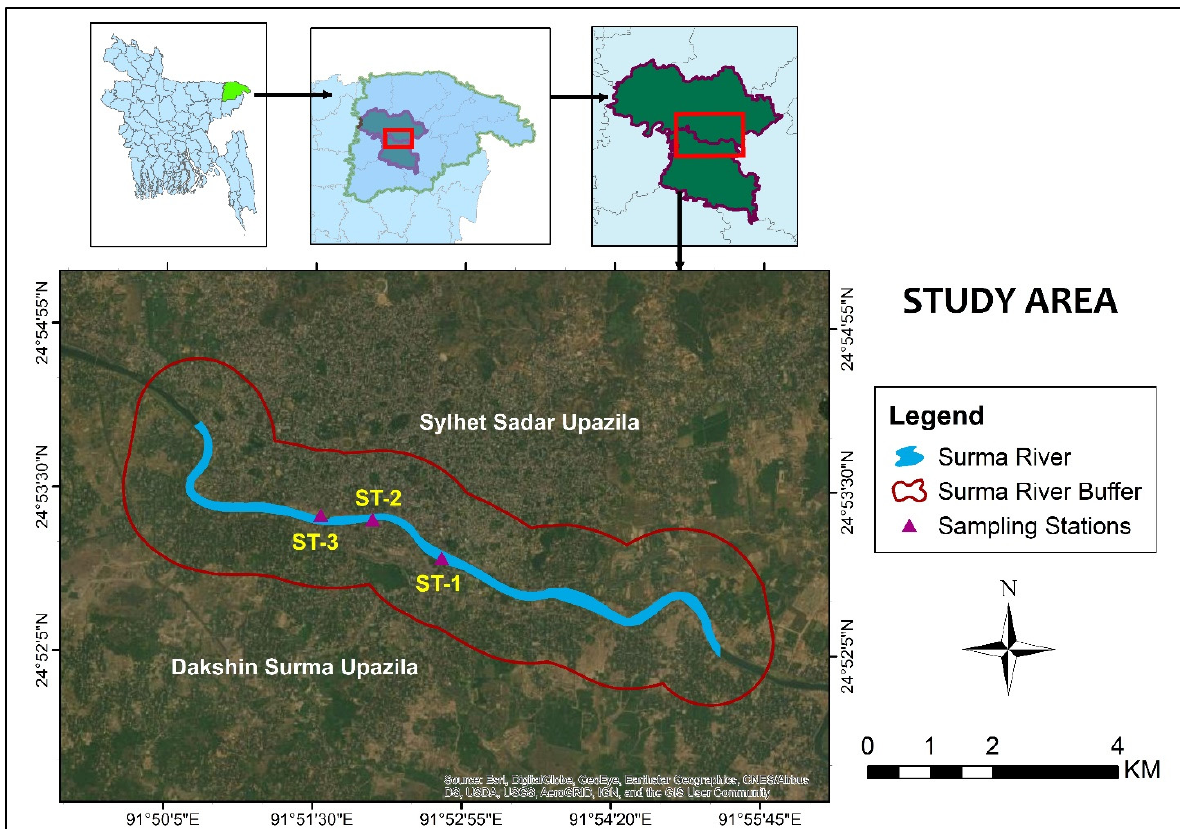
Figure 2. The study area and sampling stations.